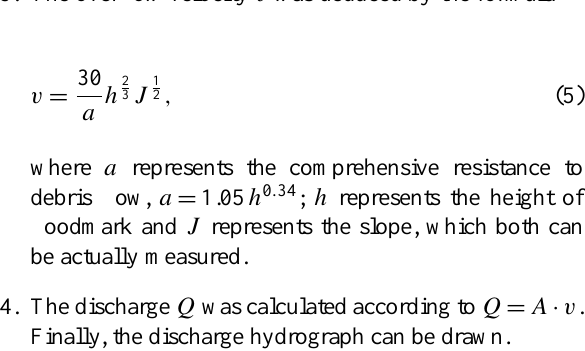
Fig.5. Time-discharge curve of Guangxieco Lake Outburst (the data is from Li and You, 6